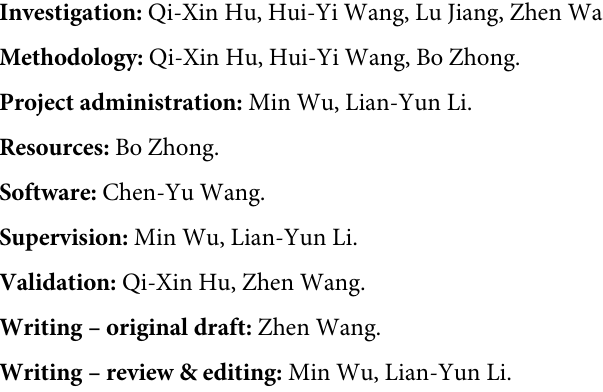
S7 Fig. LSD1 mediates TRIM25-dependent RIG-I polyubiquitination. (PDF) S8 Fig. LSD1 interacts with RIG-I independent of TRIM25. (PDF) S9 Fig. Effects of Lsd1-deficiency on RIG-I signaling in murine primary cells. (PDF) S10 Fig. Lsd1 Is Required for Rig-i-Mediated Innate Immune Response in mice. (PDF) S1 Table. List of primers for